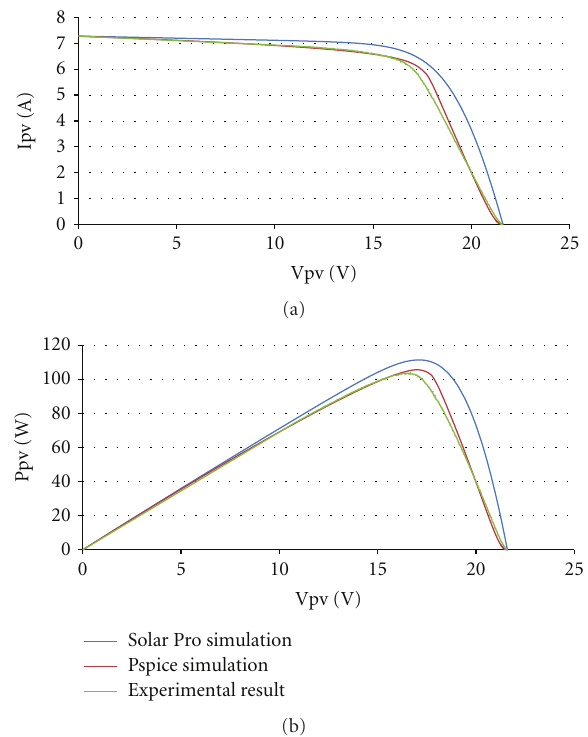
Figure 8: Comparison result for a 1 in series/4 in parallel module, (a) I - V , (b) P - V output characteristic curves.